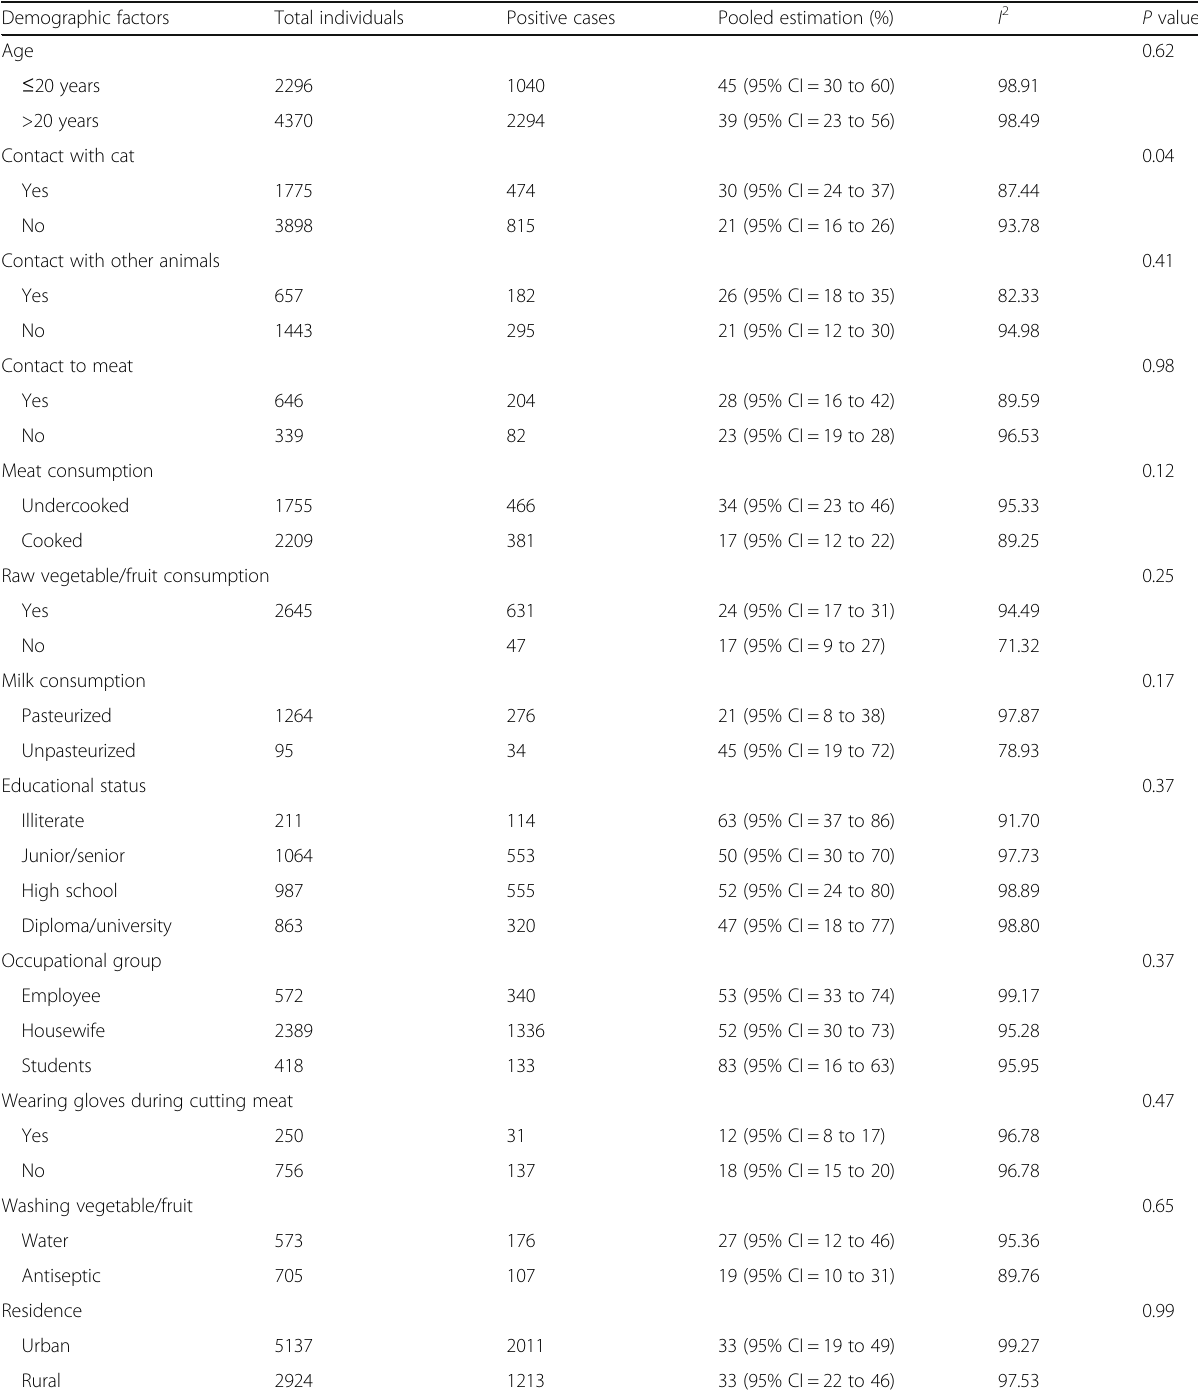
a Meta-regression